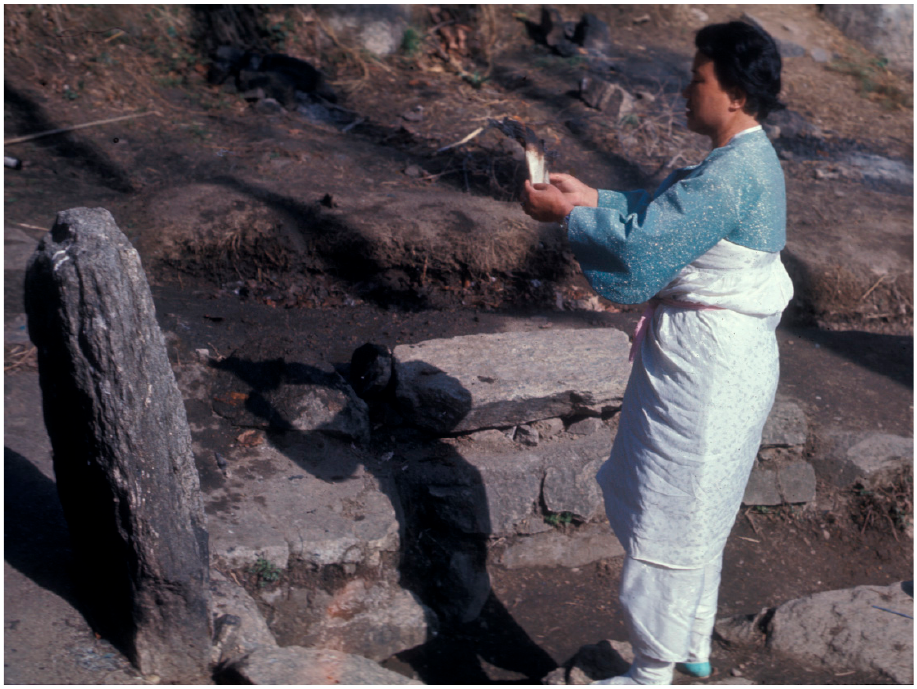
Figure 1. A mansin on Kampak Mountain purifies the site of a sacred spring, 1977. Photograph by author.